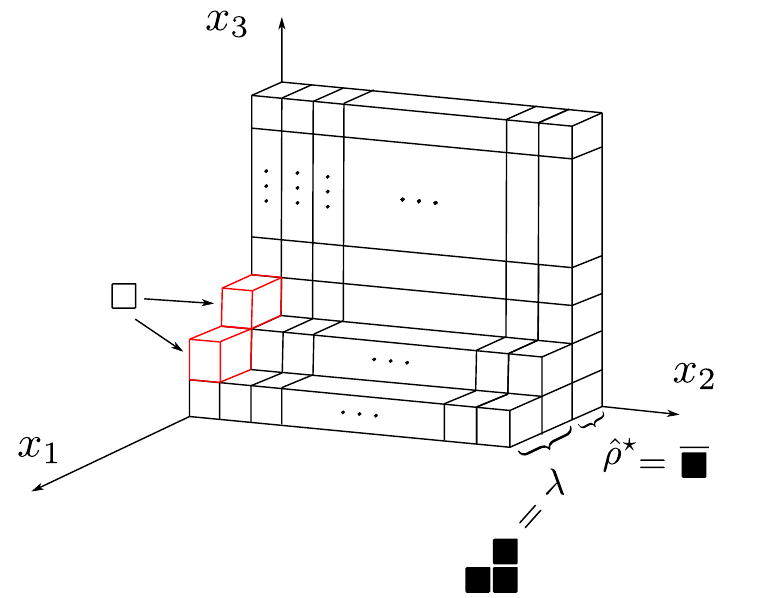
Figure 3 . Conventions for the description of internal asymptotics of twin-plane partitions in the vacuum module. Showing the un-hatted side